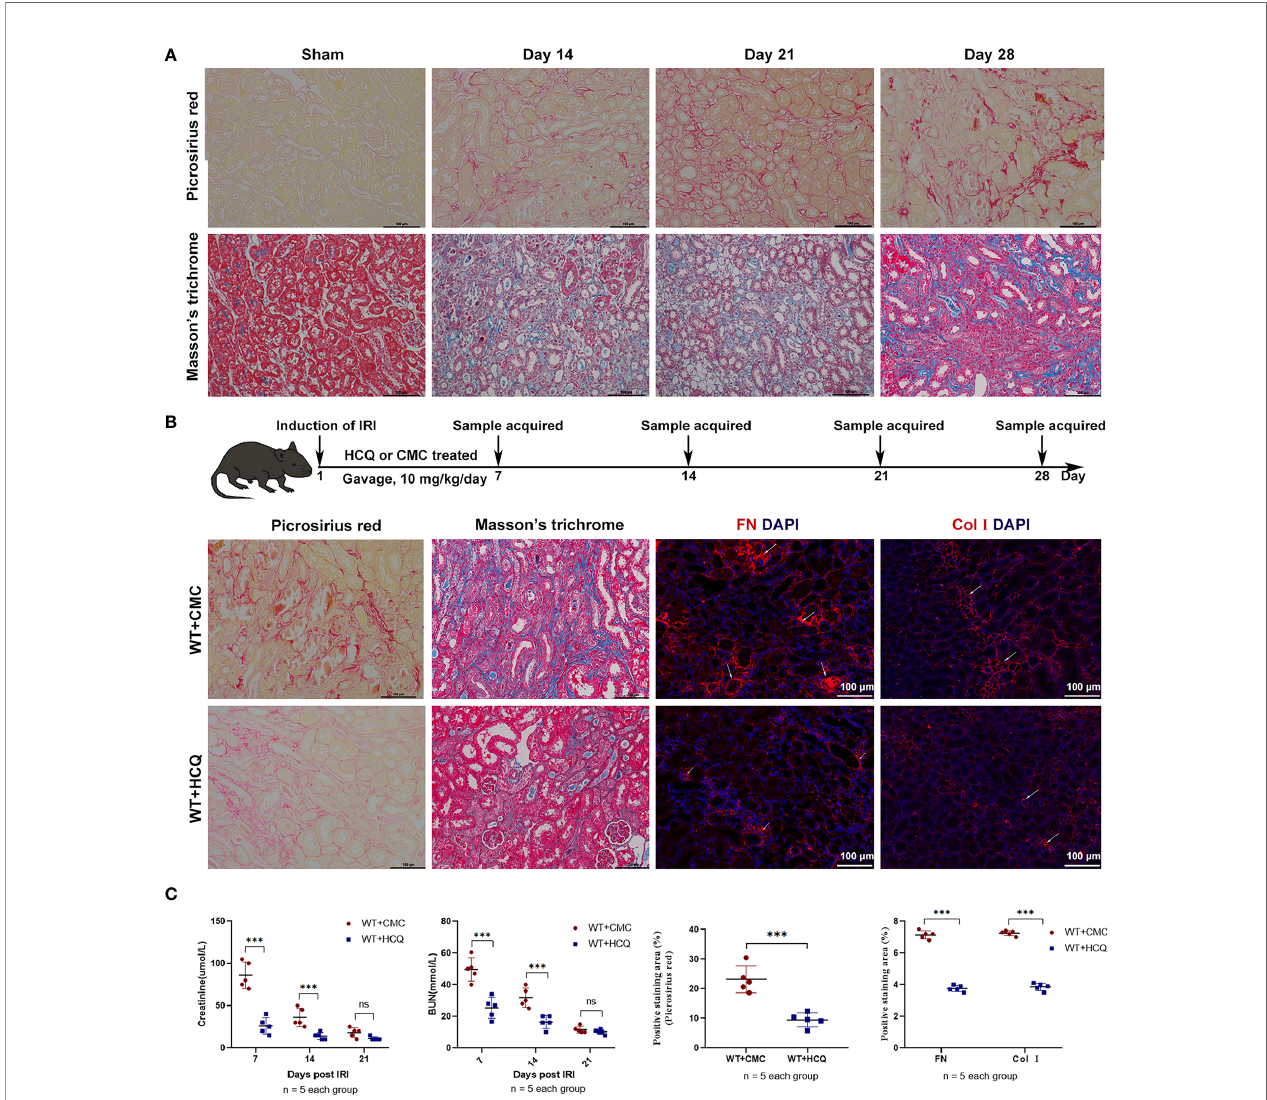
FIGURE 1 | HCQ treatment reduces renal tubulointerstitial fi brosis following IRI in vivo . Mice were subjected to IRI and treated with either CMC or HCQ (10 mg/kg/ day for 7 days). Serum samples and kidneys were harvested at various days following reperfusion. Tissue sections are representative of fi ve mice per group. (A) Representative images of Sirius red and Masson ’ s trichrome stains on normal and injured kidneys of WT mice at various time points following reperfusion. The scale bars represent 100 m m. (B) Upper panel: Design of HCQ intervention and samples acquired; Down panel: Representative images of Picrosirius red - and Masson ’ s trichrome-treated FN and Col I at day 28 following reperfusion in CMC-treated and HCQ-treated groups for WT mice; the scale bars represent 100 m m. (C) Left panel: levels of serum creatinine and BUN from CMC-treated and HCQ-treated WT mice at various time-points following reperfusion; right panel: quanti fi cation of Sirius red-stained areas in sections of murine renal cortical medullary junction and semiquantitative analysis of COL I and FN immuno fl uorescence staining. Data are represented as means ± SD and analyzed using the Student ’ s t test. Magni fi cation: 200×. NS, no signi fi cant difference, ***P <